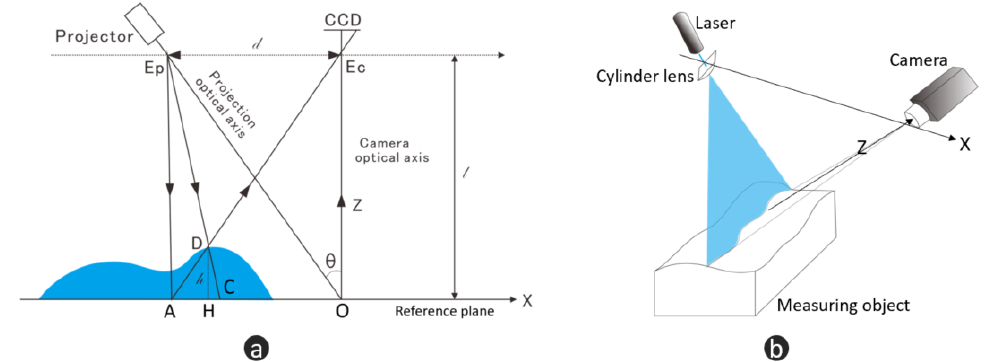
Figure 1. Schematic drawings of fringe projection and laser stripe scanning. ( a ) basic light path of Fringe projection profilometry system; ( b ) schematic diagram of laser stripe scanning